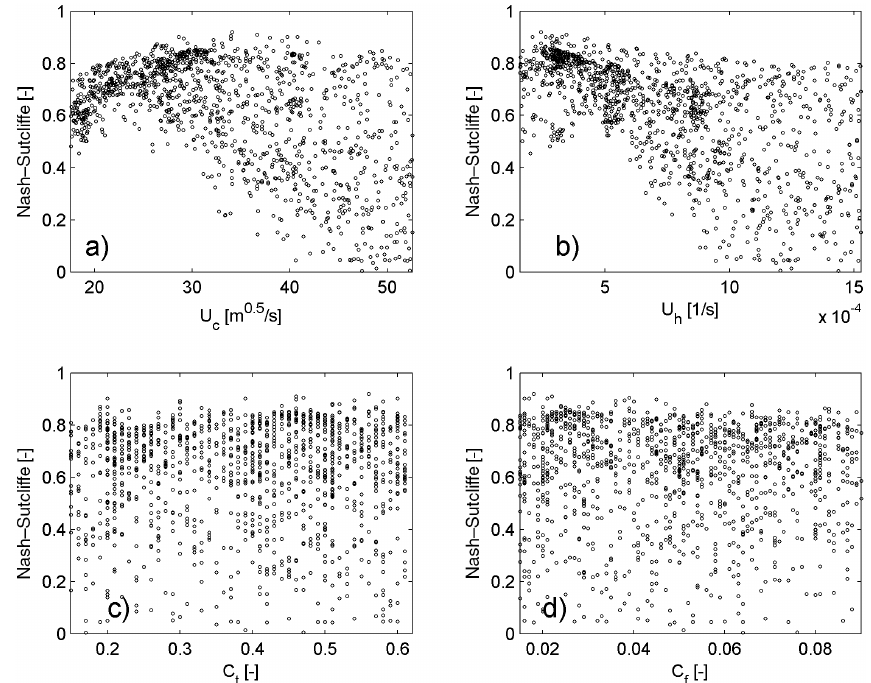
Figure 5. The Orba basin, August–September 2006. Dotty-plot representation of the NS on the hydrographs. Each subplot reports the parameter value on x axis and the value of NS statistic on y axis. The surface parameters, (a) and (b) , have quite clear ranges where NS reaches maximum values independently from other parameters. This does not occur for sub-surface flow parameters, (c) and (d) .